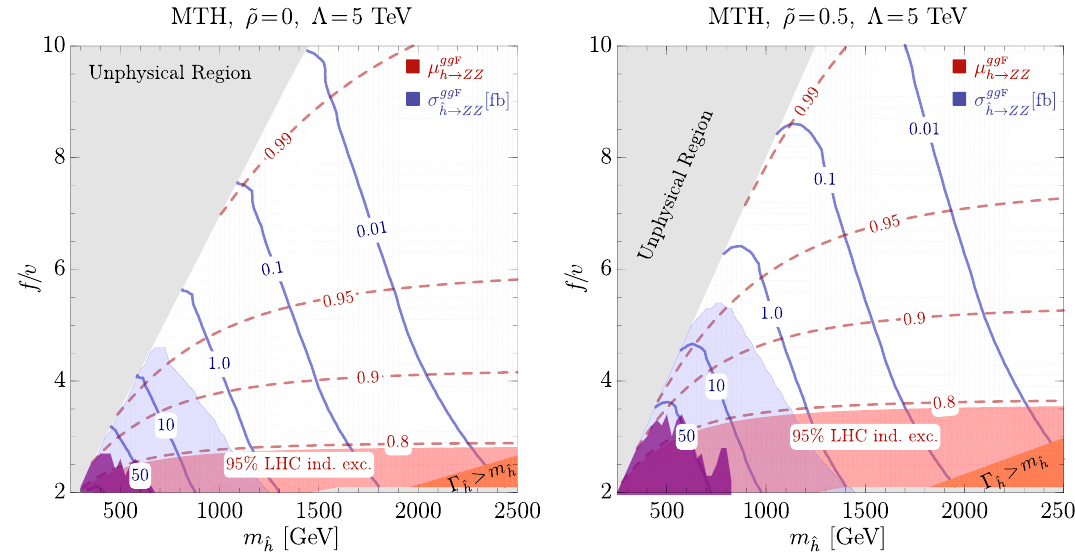
Figure 5 . These plots show parameter space in m ^ (cid:0) f=v plane for the MTH model. The contours h of heavy twin Higgs cross-section to the SM Z -boson (cid:27) gg f [fb] (solid blue) and SM Higgs signal- ^ h ! ZZ strength (cid:22) gg f (dashed red) are shown for ~ (cid:26) = 0 (left) and ~ (cid:26) = 0 : 5 (right). Shaded regions read h ! ZZ as: unphysical parameters (gray), (cid:0) ^ > m ^ (orange), exclusion by the current LHC direct searches h h ^ h ! ZZ (purple), the projected reach for direct searches ^ h ! ZZ at the HL-LHC (light-blue), and exclusion by the SM Higgs signal-strength measurements at the LHC run-1 (red).